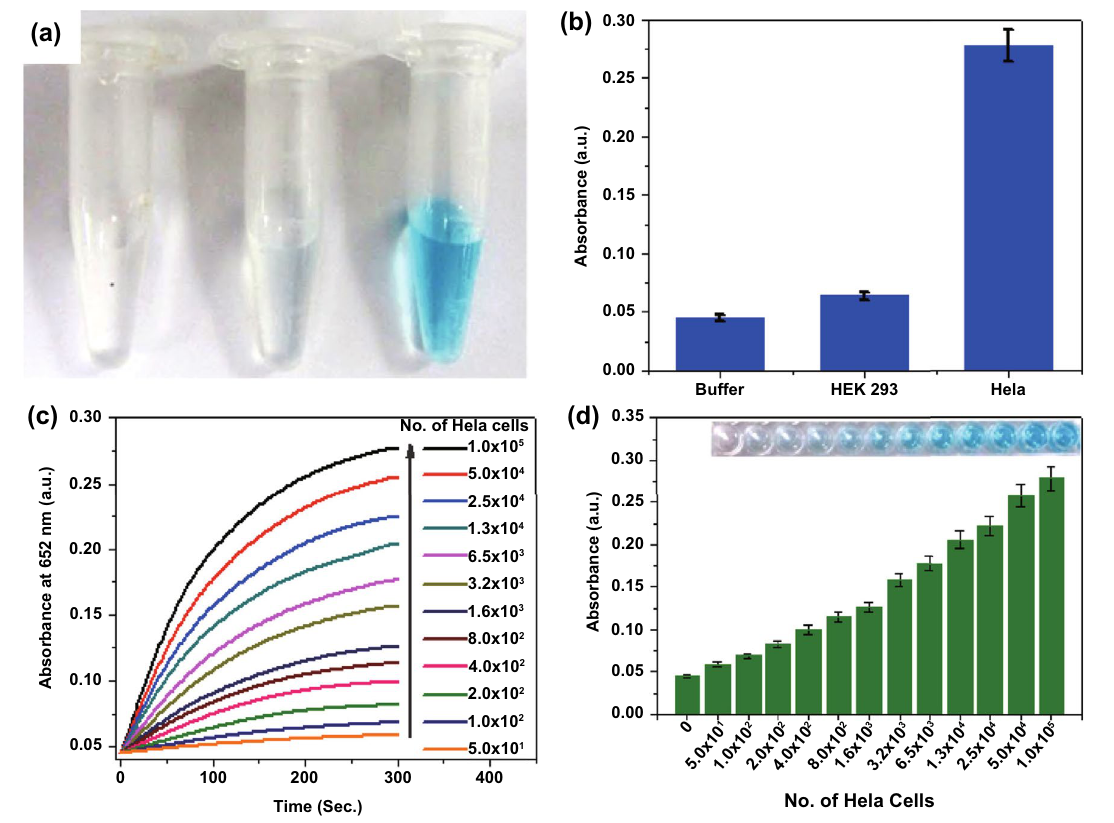
Fig. 8 a Typical photographs for cell detection using GSF@AuNPs. b Selective cancer cell detection using GSF@AuNPs. c Time-dependent absorbance at 652 nm when GSF@AuNPs and TMB were incubated with different numbers of HeLa cells. d Absorbance at 652 nm when GSF@AuNPs and TMB were incubated with different numbers of HeLa cells for 300 s. Reproduced with permission from Ref. [110]. Copyright 2015, American Chemical